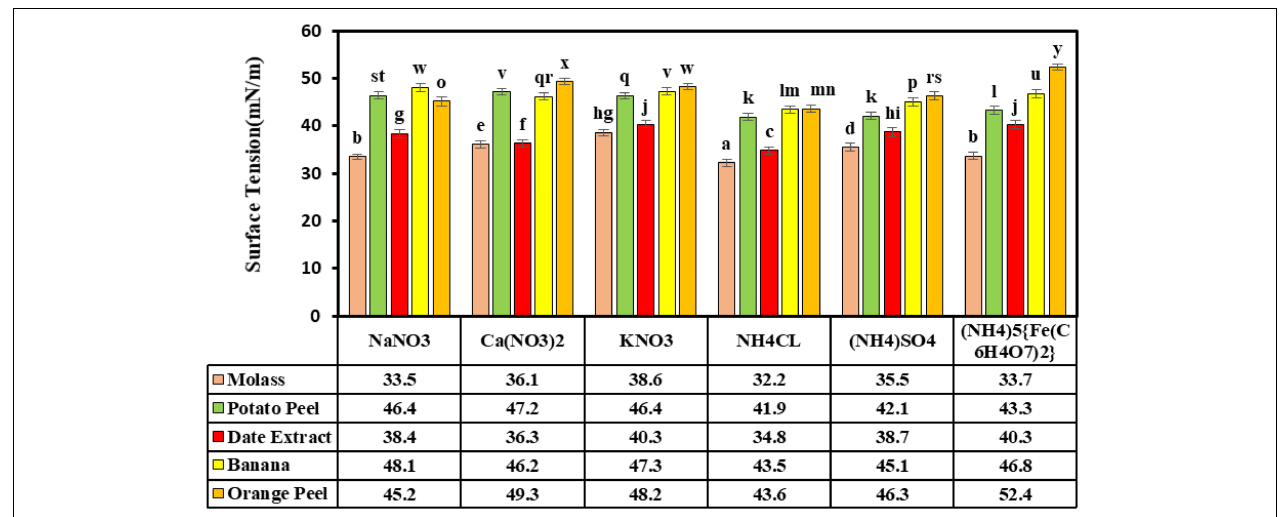
FIGURE 4 | The effects of carbon and nitrogen sources in the production of biosurfactant. Means with the same letters are not significantly different at P ≤ 0.05. Error bars indicate the standard deviation ( n = 3). Duncan test was used for comparisons of